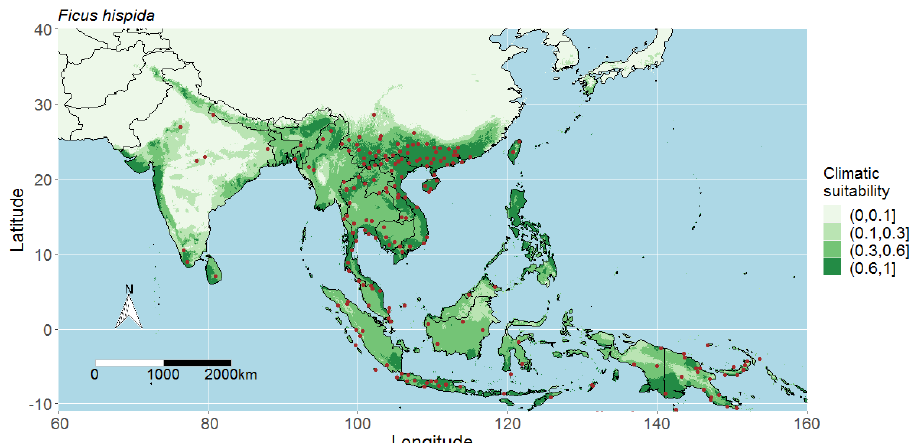
Figure 4. Ficus hispida : confirmed records (brown circles) and potential current climate suitability,